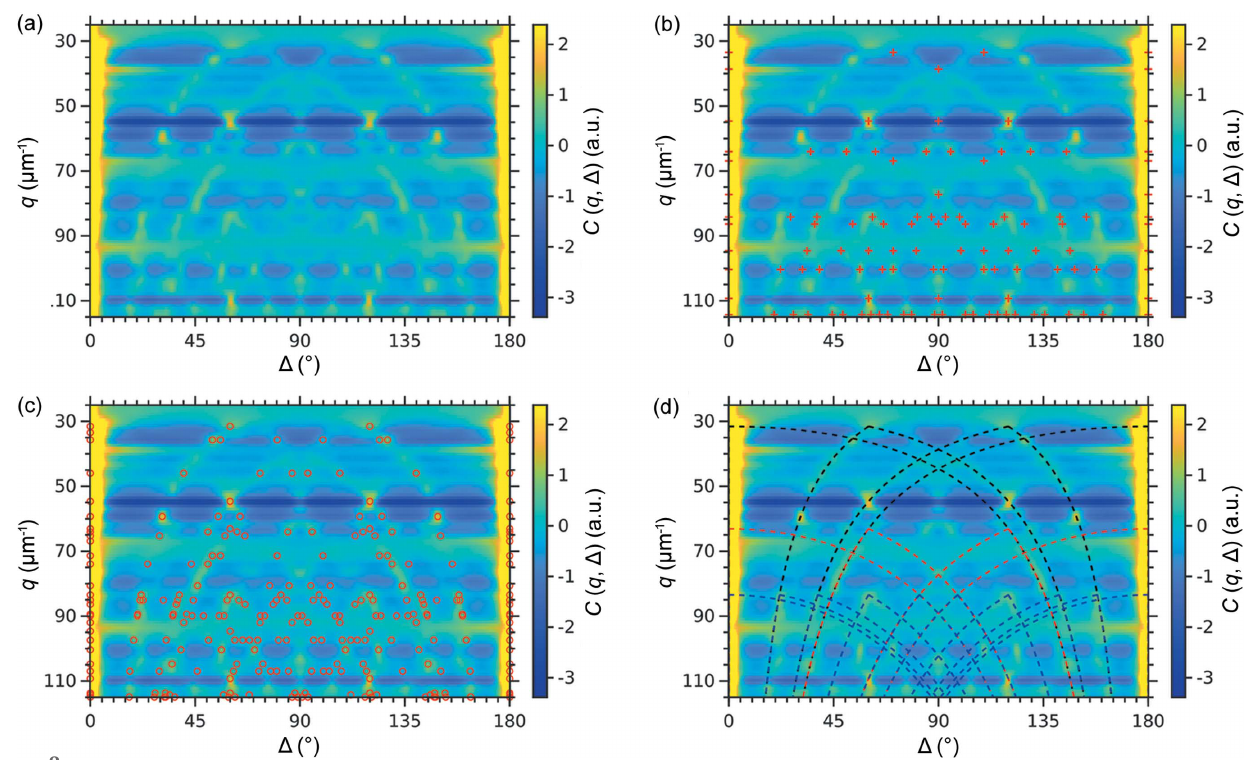
Figure 8 2D correlation maps C ( q , (cid:2) ) for the experimentally measured intensity distribution in 3D reciprocal space. ( a ) Initial correlation map. The markers in ( b )–( c ) indicate the peak positions for ( b ) f.c.c. and ( c ) h.c.p. structures calculated from the geometrical model. In ( d ) the dashed lines indicate the correlations between the Bragg rods simulated for the r.h.c.p. structure. Only correlations within 10 l (black lines), 20 l (red lines) and 21 l (blue lines) Bragg rod families are shown. Correlations between the Bragg rods from different families as well as for higher order families have been omitted for